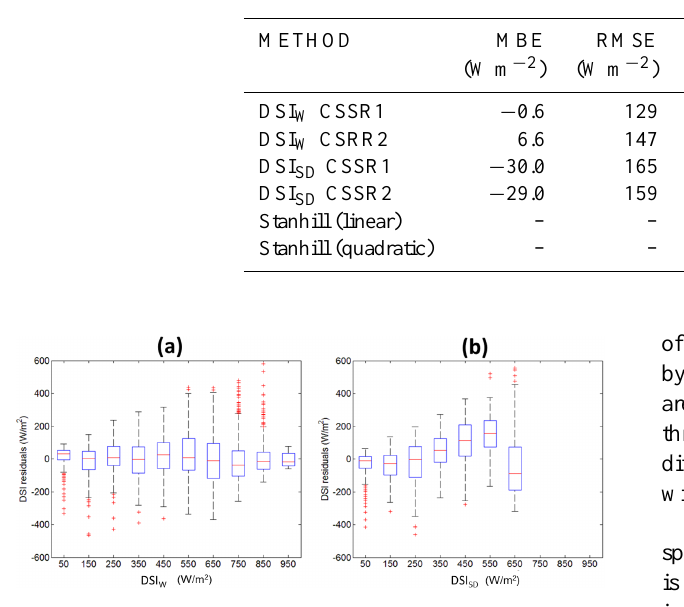
Figure 8. Box plots of the differences between estimated and true DSI for (a) estimation based on burn width and (b) estimation based on SD. It is applied for